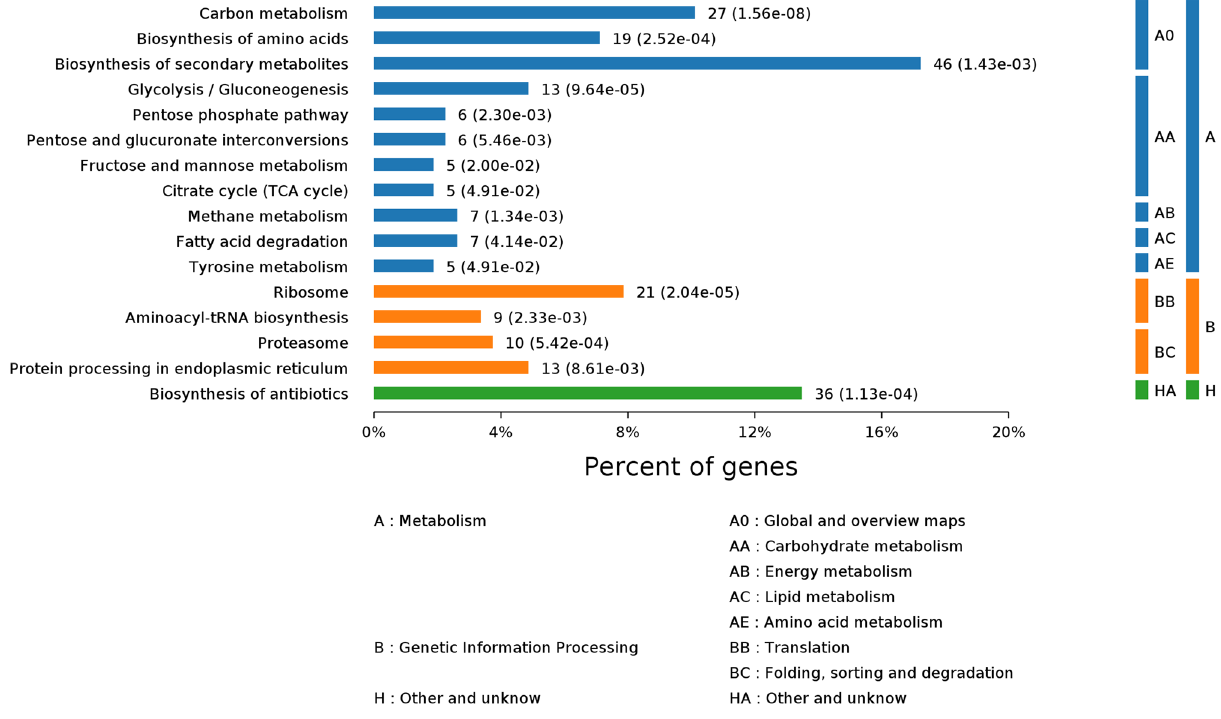
Figure 2. KEGG pathways of acetyl proteins in P.